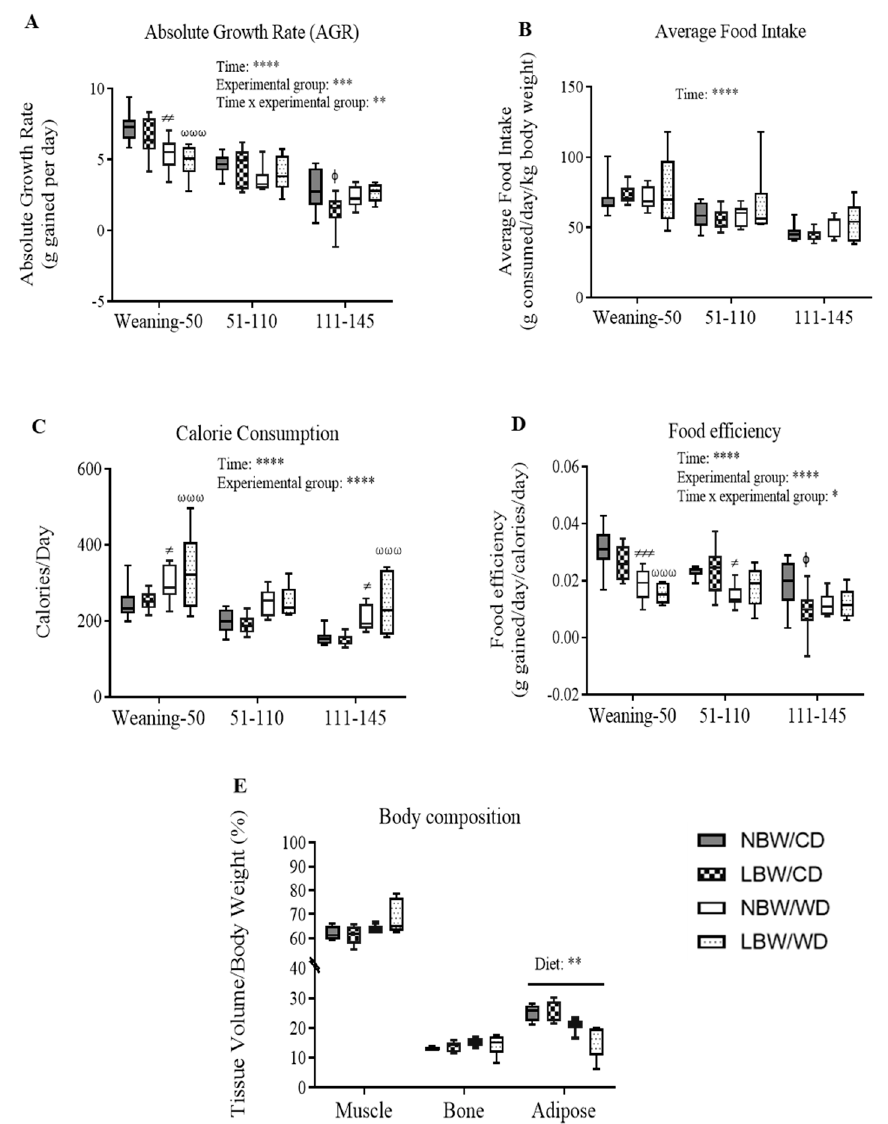
Figure 2. Post-weaning growth and feeding behavior. ( A ) Absolute growth rate (AGR) = grams gained per day. ( B ) Average food intake = grams of food consumed/kilogram body weight. ( C ) Calorie consumption = calories consumed per day. ( D ) Food efficiency = grams gained per day/calories consumed per day. Data presented are min. to max. box and whisker plots for 6–11 ani- mals/experimental group. Two-way repeated-measures ANOVA showed that the main effects of ex- perimental group, time, and time × experimental group interaction: * p < 0.05; ** p < 0.01; *** p < 0.001; **** p < 0.0001. φ p < 0.05 for the difference between NBW/CD and LBW/CD, (cid:54) = p < 0.05, (cid:54) = (cid:54) = p < 0.01 and (cid:54) = (cid:54) = (cid:54) = p < 0.001 for the difference between NBW/CD and NBW/WD, and ωωω p < 0.001 for NBW/CD versus LBW/WD following a Bonferroni post hoc test. ( E ) For body composition